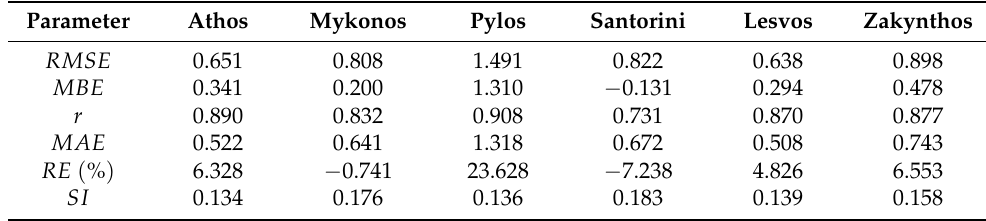
Table 3. Results of data evaluation of the wave energy period T e obtained from ERA5 and in- situ measurements. Parameter Athos